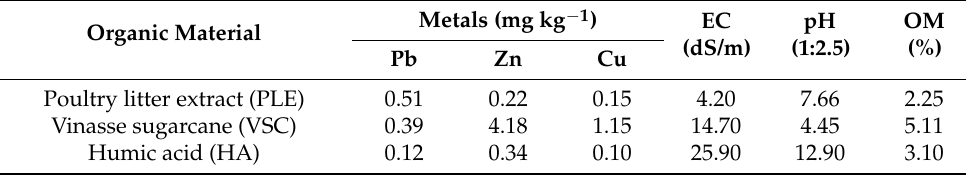
Table 2. Some chemical properties of the examined organic